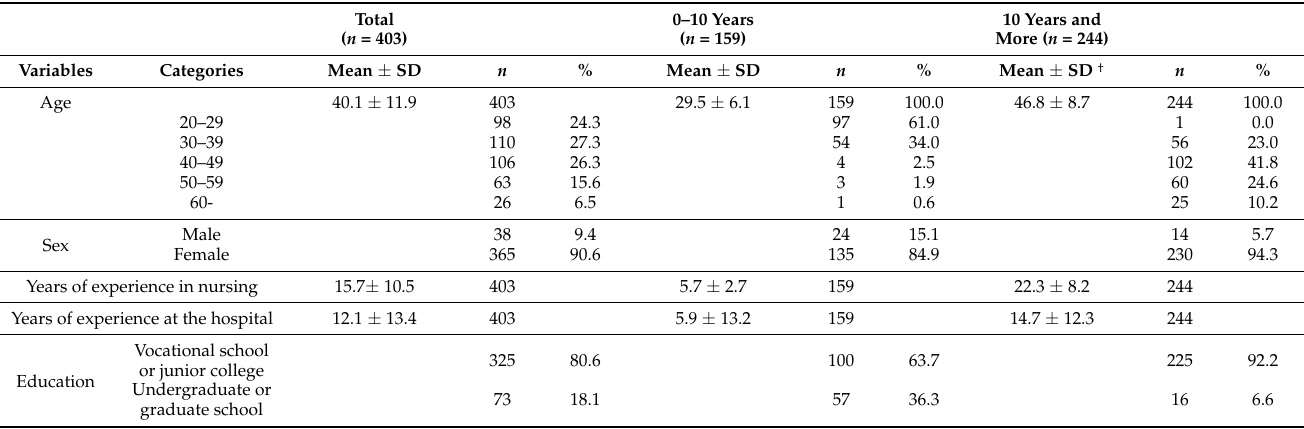
Table 1. Demographic traits of the participants according to years of work experience (Time 1).